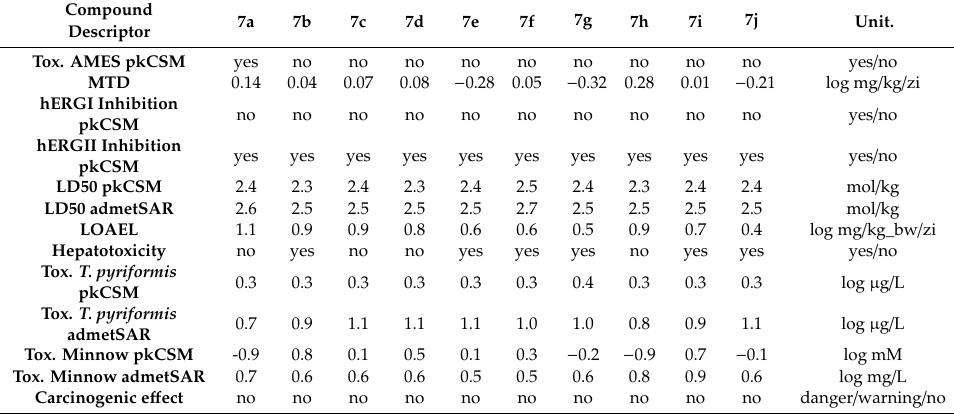
Table 3. Toxicity predictions for compounds 7a – j